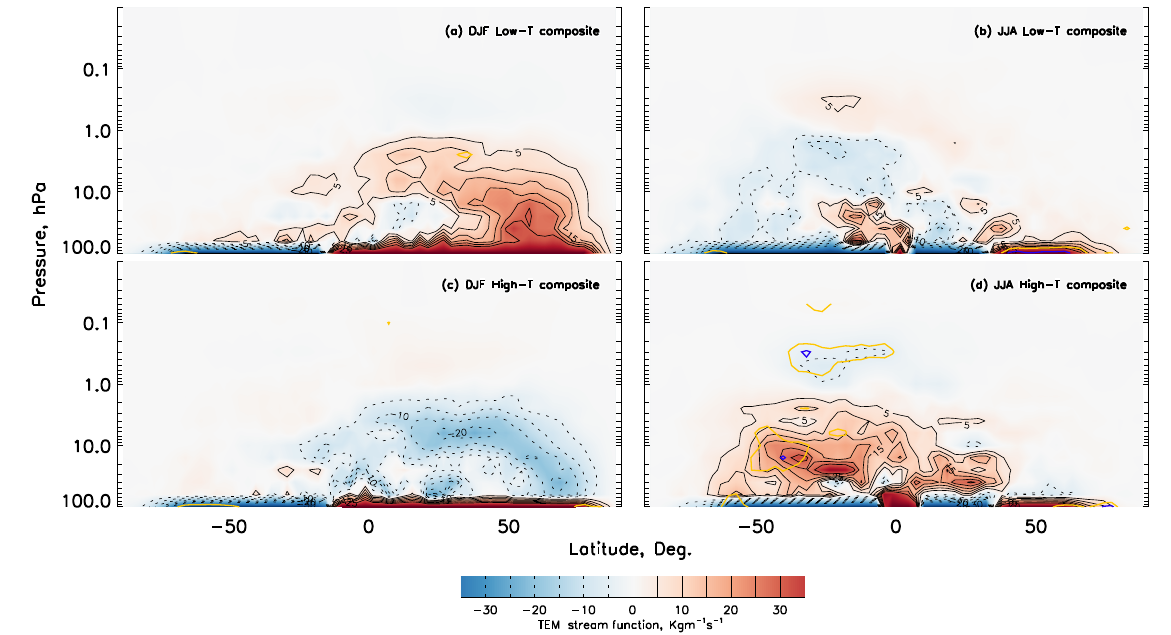
Figure 5. The median of the transformed Eulerian mean stream function (TEMS) anomalies for (a) DJF low-temperature events, (b) JJA low- T events, (c) DJF high- T events, (d) JJA high- T events for the same months as in Fig. 3c–f. Contours lines (solid: positive; dashed: negative) and colours are given in the legend. Positive values indicate clockwise acceleration along the contour lines; negative are anti-clockwise. Data are from the SOCOL model in specified-dynamics